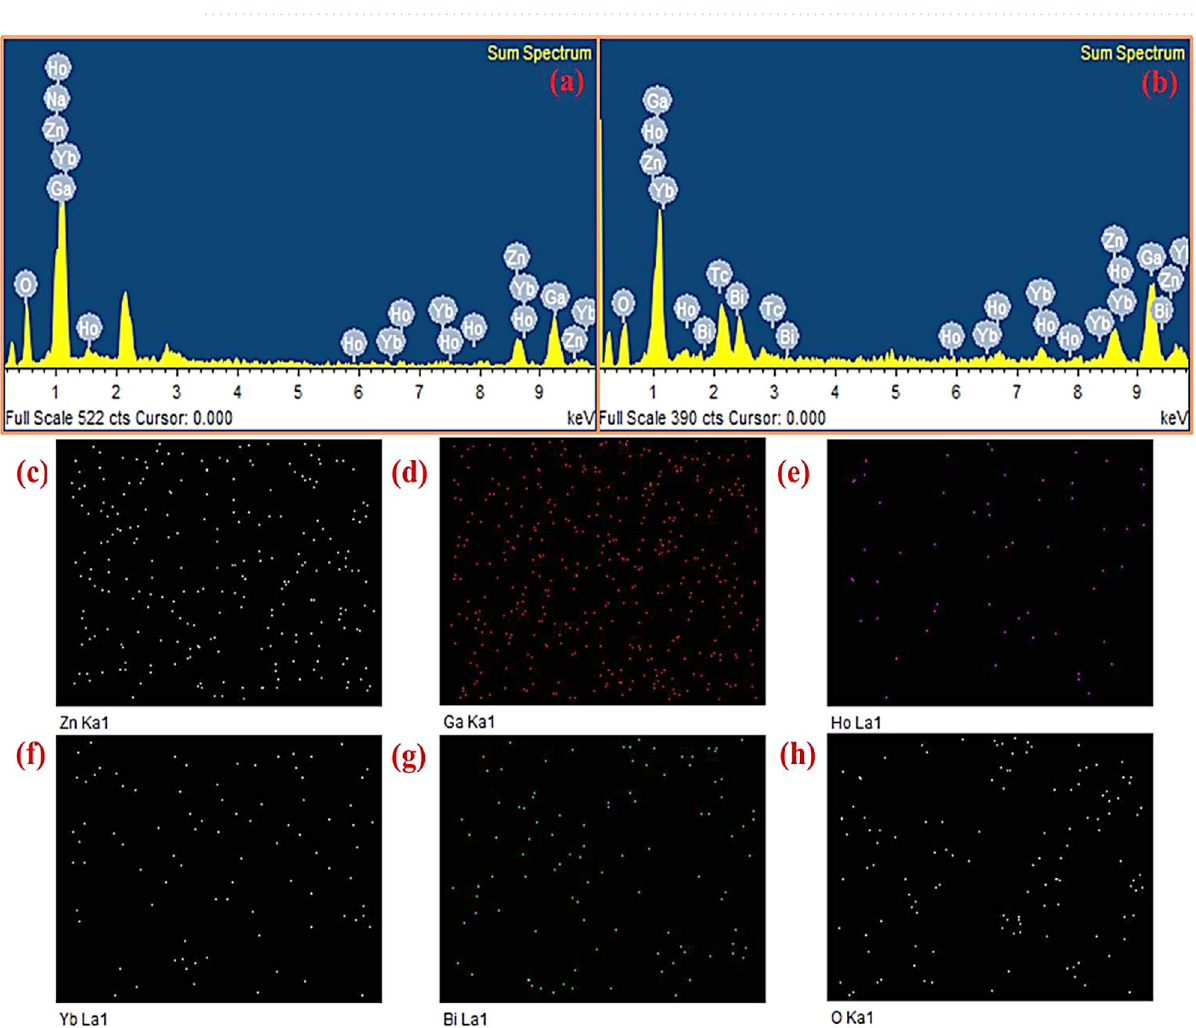
Figure 3. ( a , b ) The EDS spectra of the Ho 3+ /Yb 3+ /0Bi 3+ and Ho 3+ /Yb 3+ /5Bi 3+ co-doped phosphors. ( c – h ) represent the EDS mappings of Zn, Ga, Ho, Yb, Bi and O constituents in the Ho 3+ /Yb 3+ /5Bi 3+ co-doped phosphor generated by using INCA